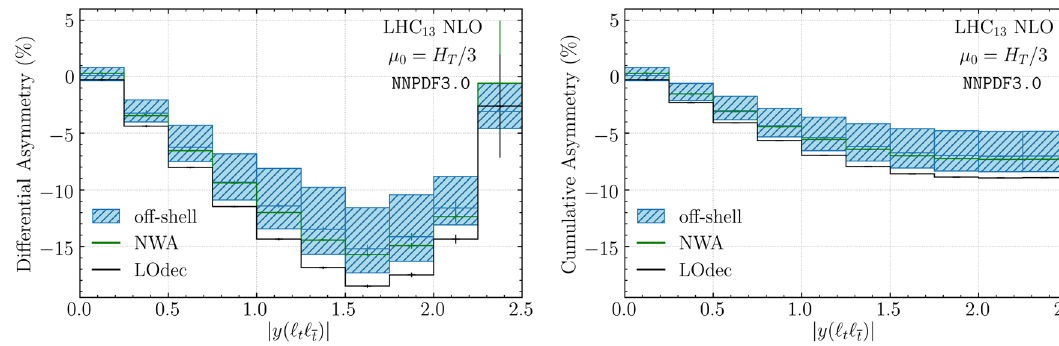
Fig. 8 As in Fig. 7 but for | y ((cid:4) t (cid:4) ¯ t ) |